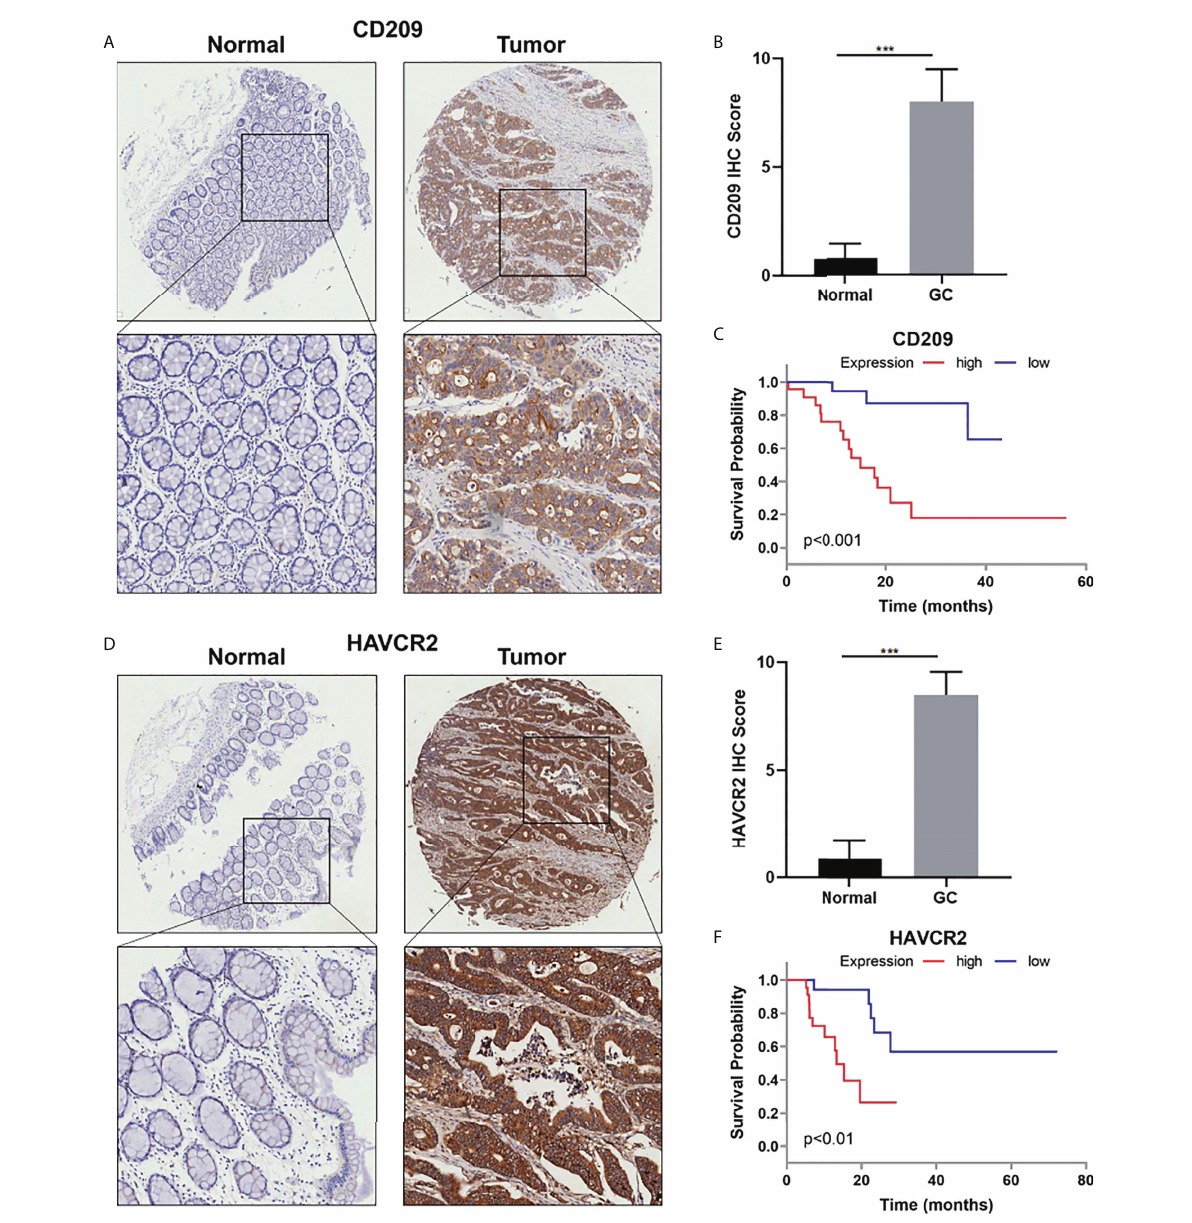
FIGURE 8 (A) Representative IHC staining for CD209 in GC and adjacent non-tumor tissues. (B) Quanti fi cation of (A) . (C) The overall survival analysis was plotted using Kaplan – Meier Plotter for patients with GC by IHC level of CD209. (D) Representative IHC staining for HAVCR2 in GC and adjacent non-tumor tissues. (E) Quanti fi cation of (D) . (F) The overall survival analysis was plotted using Kaplan – Meier Plotter for patients with GC by IHC level of HAVCR2. ***p